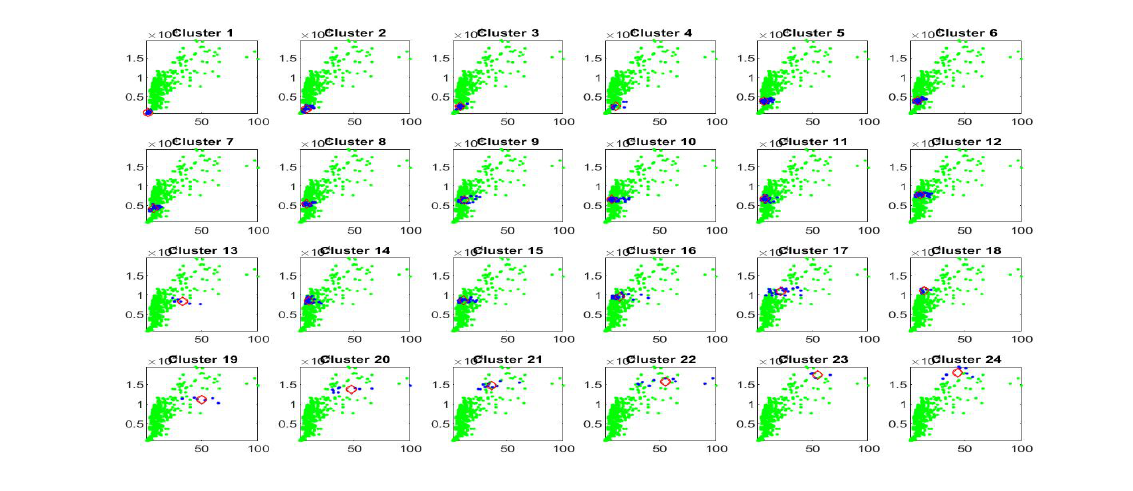
Figure 13. The blue points correspond to the observations ( GT 100 t , BitCoin t ) assigned to each cluster by clustering C. The red points give the centroid values relative to two variables GT 100 and BitCoin .